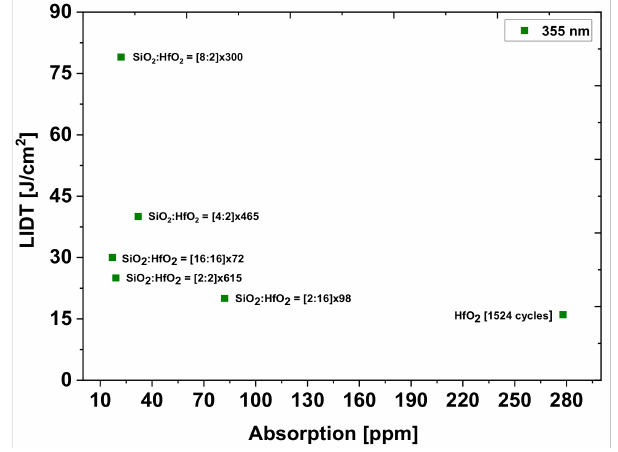
Figure 13. The effect of absorption on LIDT of selected heterostructures.